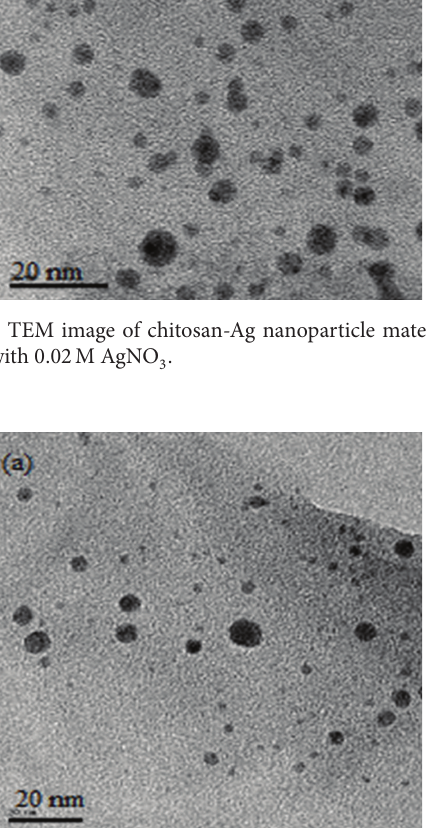
Figure 5: TEM image of chitosan-Ag nanoparticle materials synthe- sized with 0.04 M AgNO 3 .